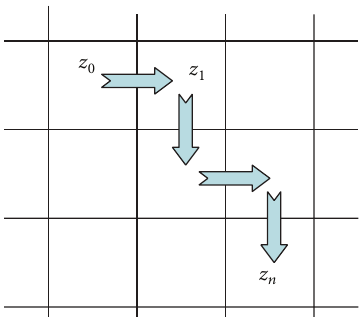
Figure 3: Movement of occupants in cascade from zone 𝑧 0 to zone 𝑧 𝑛